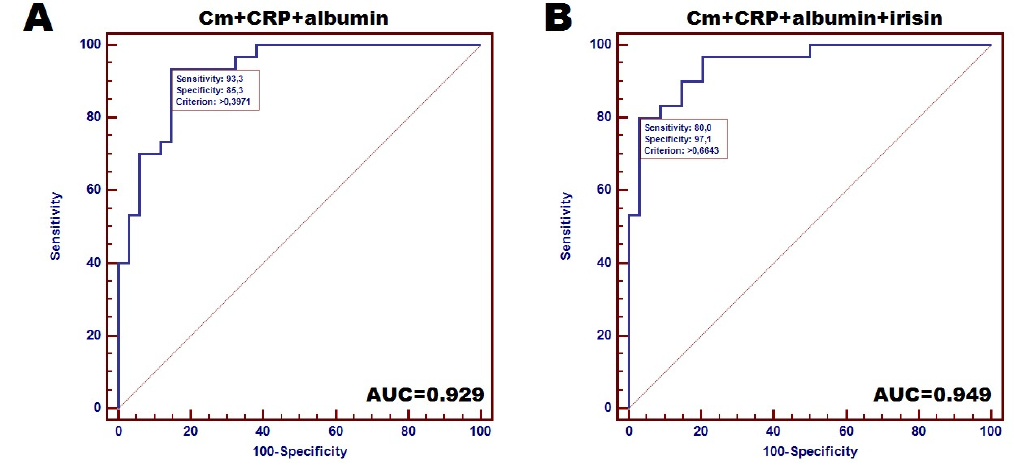
Figure 2. Accuracy of designed tests for distinguishing between cachectic and non-cachectic CHF female patients: A —Receiver operating curves (ROC) for combined analysis of 3 markers (Cm, CRP and albumin), B —ROC for 4 markers-based tests (combination of CM, CRP, albumin and irisin). Diagnostic accuracy of particular markers is demonstrated in the table 5. Table 5. Tests accuracy of CRP, irisin, albumin, Cm and their combination to distinguish cachectic CHF patients from non-cachectic CHF individuals.